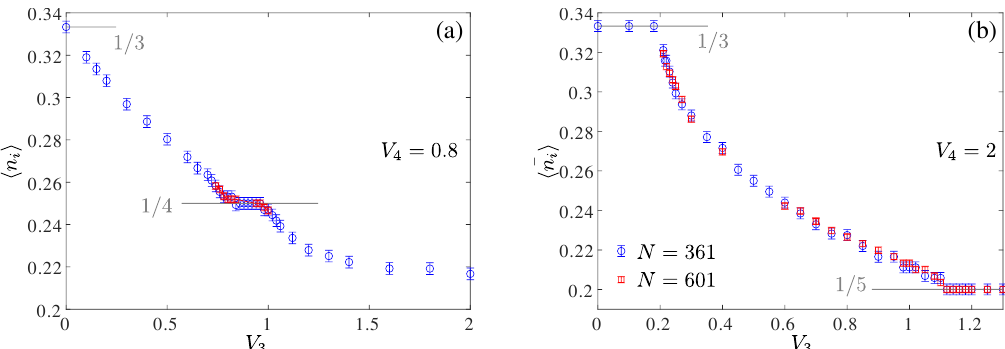
= 0.8 along (a) V 3 4